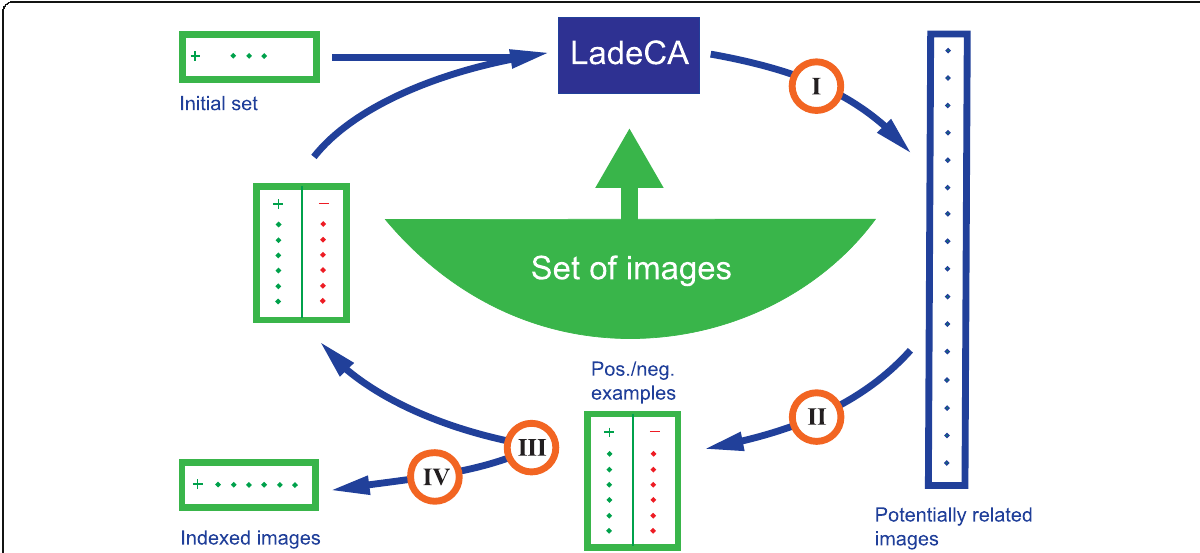
Fig. 18 Indexing of categories instead of individual images using LadeCA. Set of images: a set of images to be indexed. Initial set: one or more related images specified by the user or suggested by LadeCA based on an analysis of the given set of images. Step I: based on the given set of positive and negative examples that describe a category (or the initial set), LadeCA creates a classifier, which in turn determines images potentially belonging to the category. Step II: supported by LadeCA, the user divides the given images as belonging/belonging to the category. Step III: the user decides whether the category defined by the positive images is complete. Step IV: the user indexes the category defined by the positive